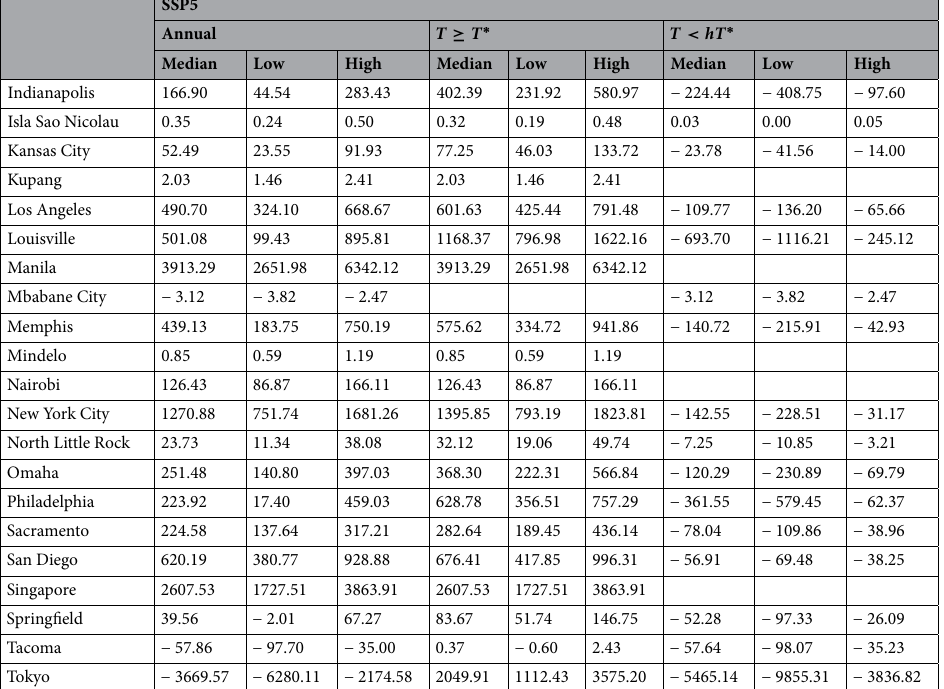
Table 1. Change in total annual GWh across GCMs under RCP 8.5 at the median, 5th (low) and 95th (high) percentiles under SSP3 and SSP5. Median, 5th (low) and 95th (high) percentiles of change under both SSPs are also presented for future temperatures ≥ T ∗ and < T ∗